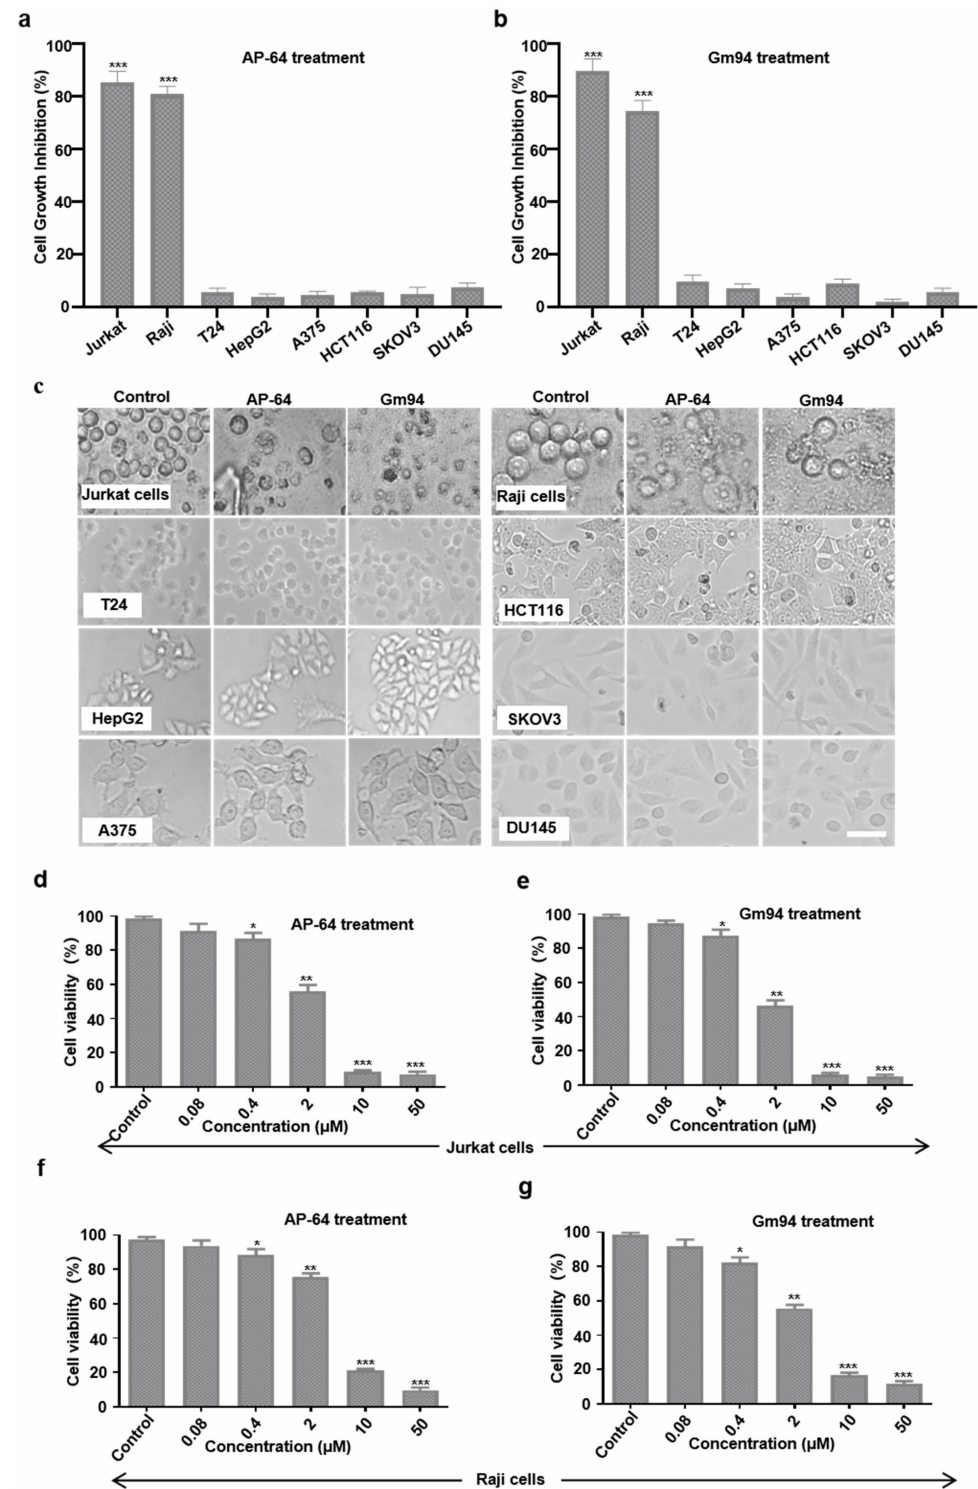
Figure 5. Antitumor activity. ( a , b ) Human tumor cells were treated with AP-64 ( a ) or Gm94 ( b ) at 10 µ M for 24 h and cell growth inhibition was measured using the CCK-8 assay. ( c ) Representative images of the cells 24 h after treatment with AP-64 or Gm94 at 10 µ M. The cell lines T24, HepG2, A375, HCT116, SKOV3, and DU145 were representative for Bladder cancer, liver cancer, melanoma, colon cancer, ovarian cancer, and prostate cancer tissues, respectively. ( d – g ) Cell viability of Jurkat or Raji cells after treatment with the proteins at indicated concentrations for 24 h. All error bars represent SD. * p < 0.05, ** p < 0.01, *** p < 0.001. Scale bar, 100 µ